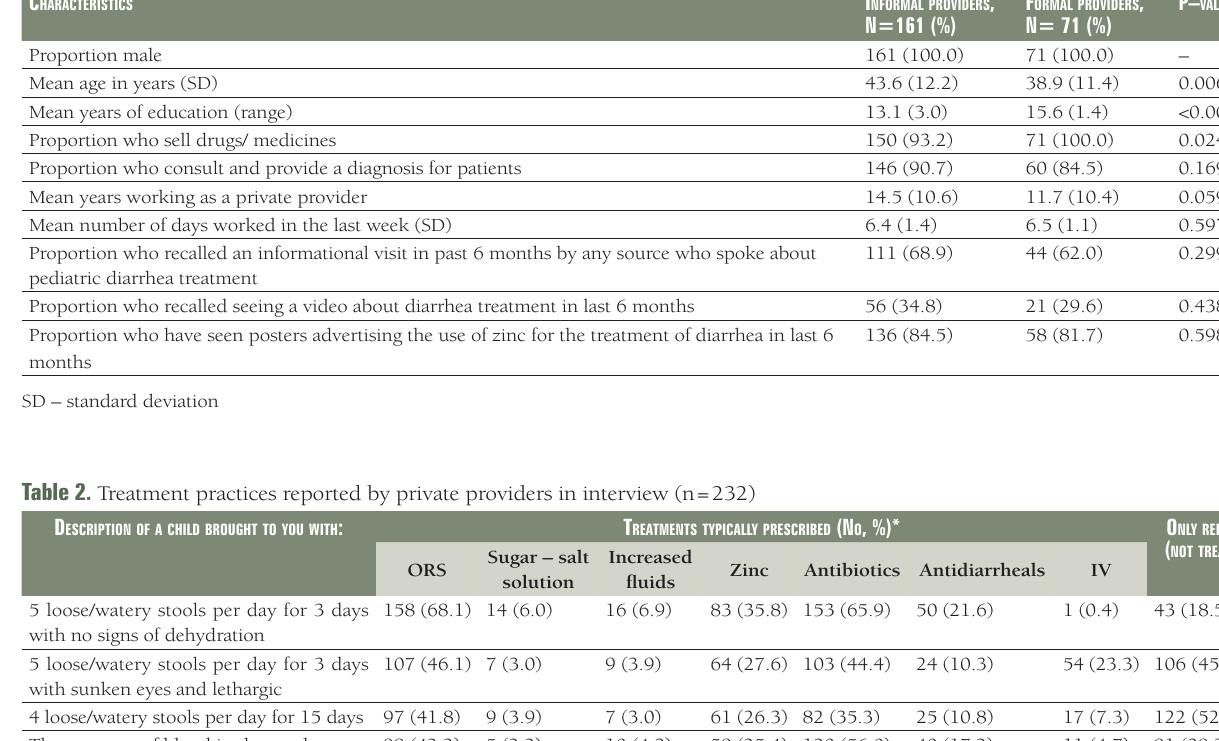
Table 1. Comparison of the characteristics of informal and formal providers C haraCteristiCs